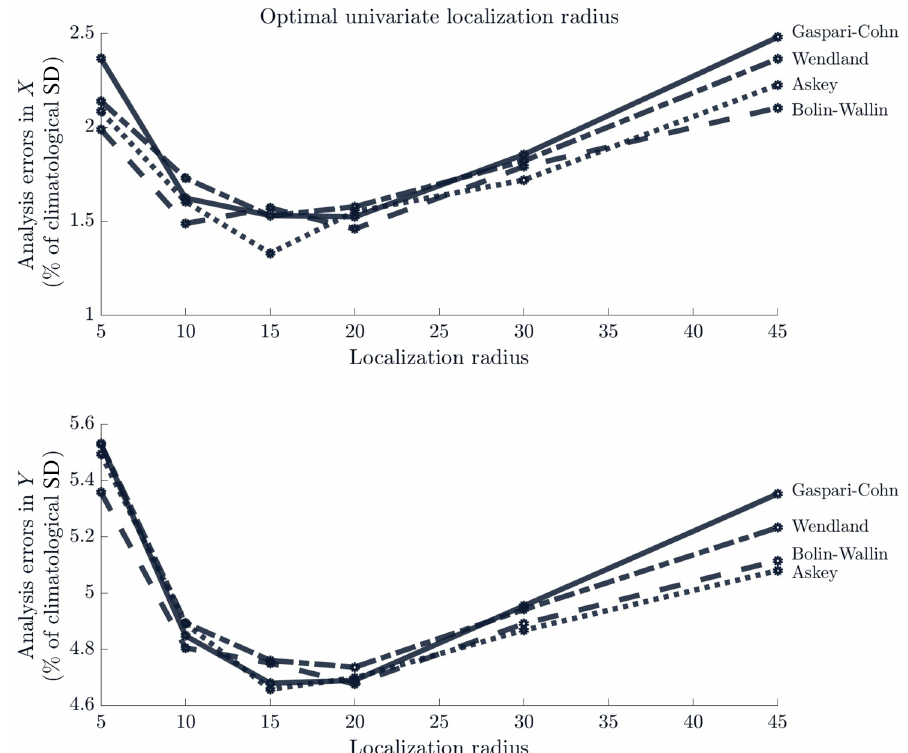
Figure B2. Analysis errors for different univariate localization radii. Analysis errors are calculated as RMS deviations from the truth and are scaled by the climatological standard deviation of the associated process. Considering all functions, the best performance comes when R =